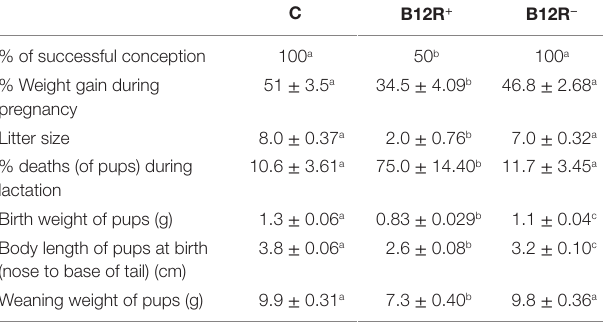
TaBle 5 | gestational outcome.